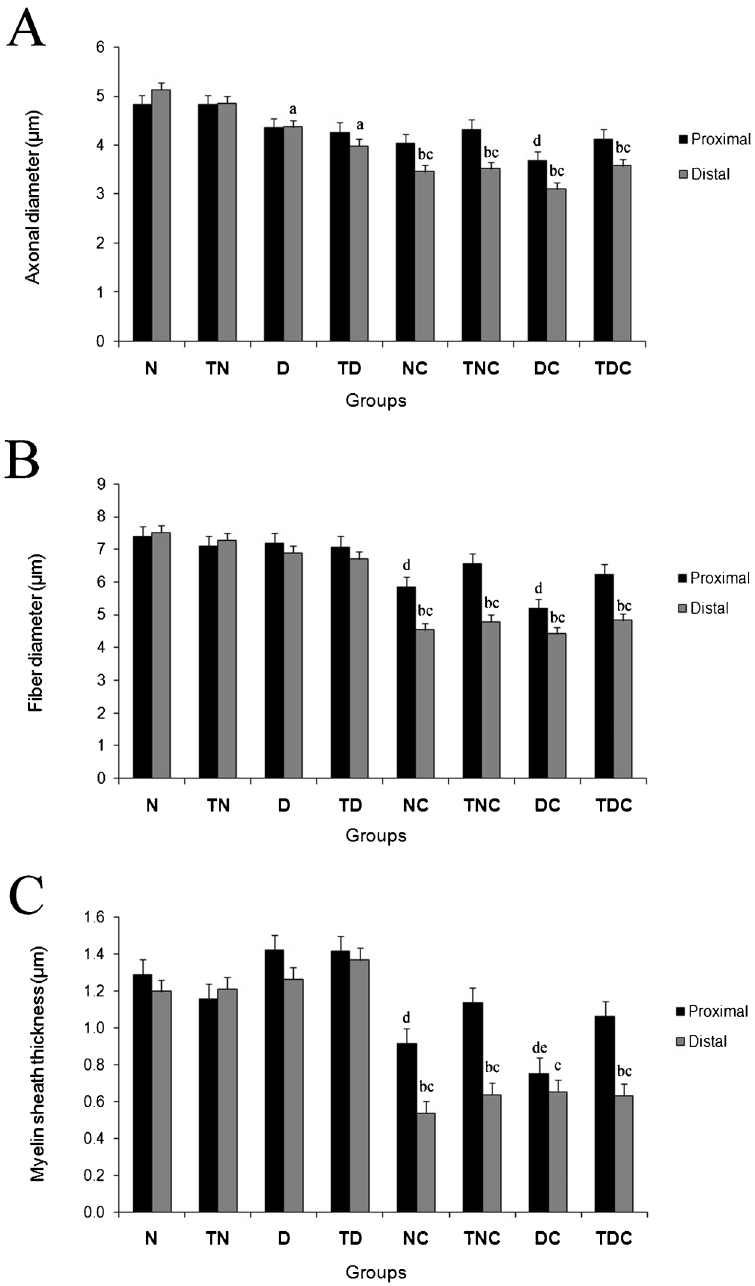
Figure 5 - Graphs showing the morphometrical parameters in the proximal and distal portions of the sciatic nerve in non-diabetic (N, n=6), trained non-diabetic (TN, n=6), diabetic (D, n=6), trained diabetic (TD, n=8), non-diabetic submitted to sciatic nerve crush (NC, n=6), trained non-diabetic submitted to sciatic nerve crush (TNC, n=6), diabetic submitted to sciatic nerve crush (DC, n=9) and trained diabetic submitted to sciatic nerve crush (TDC, n=7) groups. A: average axonal diameter; B: average myelinated fiber diameter; C: average myelin sheath thickness. Data are expressed as means ¡ SEM. a P , 0.05 vs. distal portion in the N and TN groups; b P , 0.05 vs. proximal portion in the same group; c P , 0.05 vs. distal portion in the N, TN, D, TD groups; d P , 0.05 vs. proximal portion in the N, TN, D, TD groups; e P , 0.05 vs. proximal portion in the TNC and